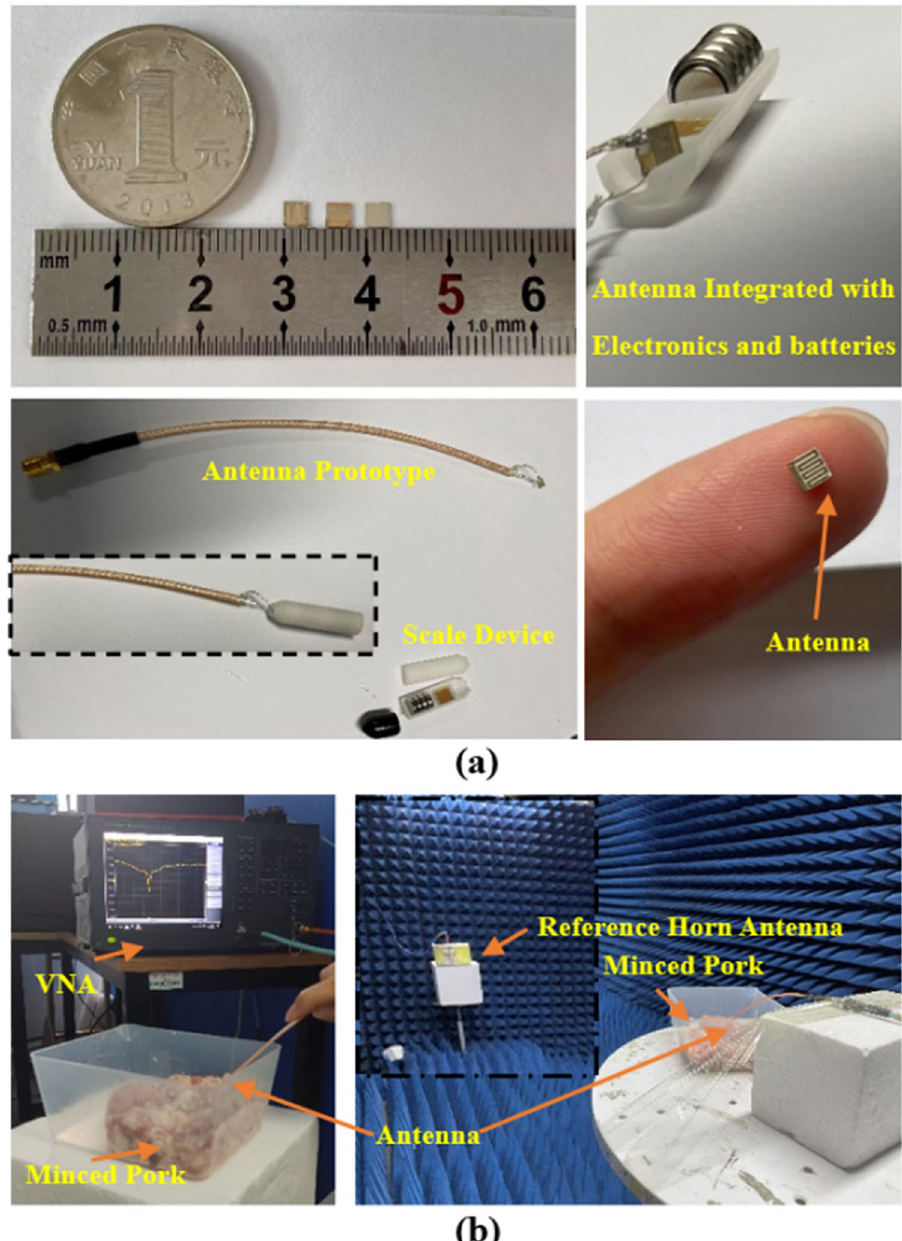
Figure 4. Antenna and test environment. ( a ) Antenna components and 3D printed cardiac pacemaker system models. ( b ) Antenna test S parameters and gain environment